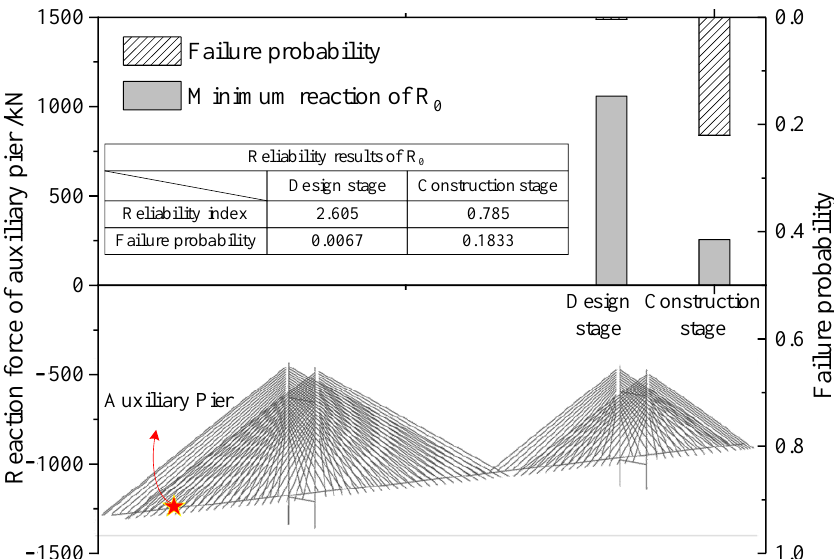
Figure 13. Negative reaction risk assessment under the live load.